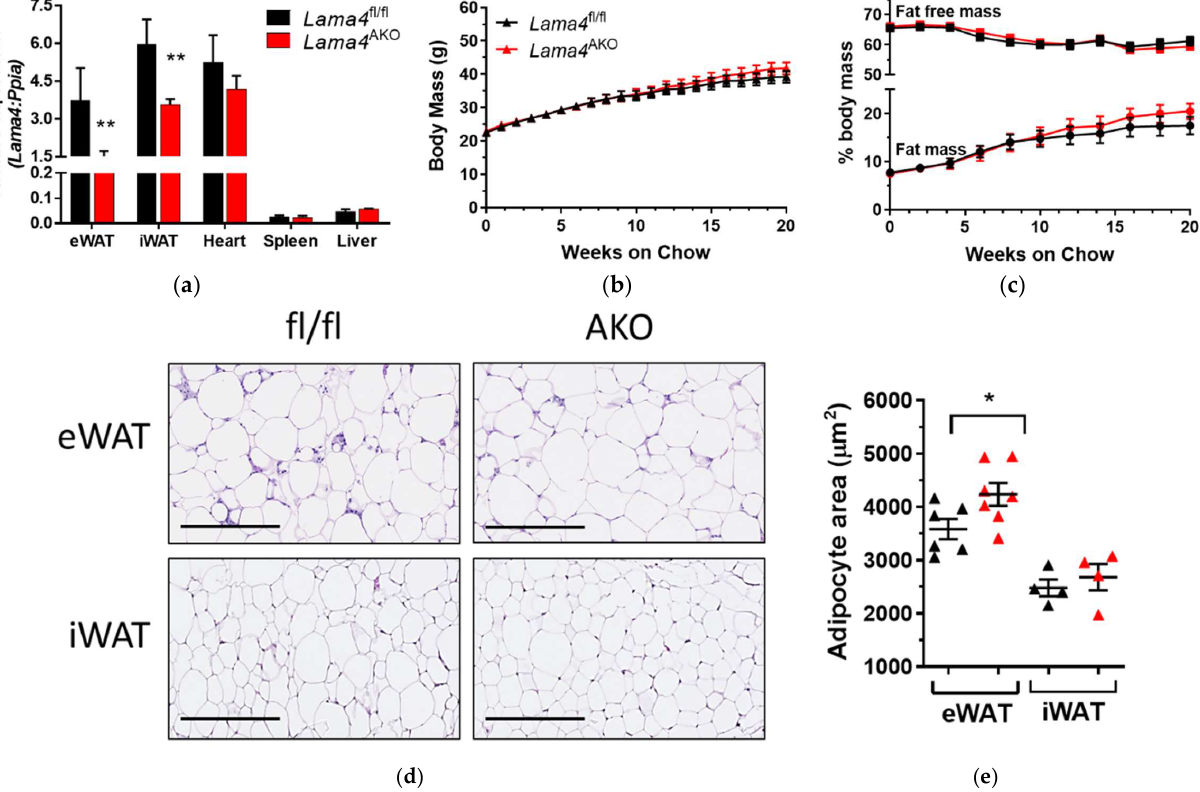
Figure 3. Mice with adipocyte-specific LAMA4 deletion exhibit increased eWAT adipocyte area when maintained on a chow diet. Male Lama4 fl/fl (fl/fl) and Lama4 AKO (AKO) mice were provided a chow diet from weaning until 24 weeks of age; body weight was measured weekly and body composition was measured via NMR every other week. ( a ) Knockdown of Lama4 was confirmed in eWAT and iWAT; heart is shown as a positive control ( n = 3–4 per genotype). Black bars represent Lama4 fl/fl mice and red bars represent Lama4 AKO mice. ( b ) There were no differences in body weight between Lama4 fl/fl (black) and Lama4 AKO mice (red) ( n = 16–18 per genotype). ( c ) Adiposity did not differ between Lama4 fl/fl (black) and Lama4 AKO mice (red) ( n = 16–18 per genotype). ( d ) Representative images of H&E-stained eWAT and iWAT ( n = 4–6 per group). ( e ) Adipocyte area is significantly increased in eWAT, but not in iWAT, of chow-fed Lama4 AKO mice ( n = 4–7 per genotype per tissue). Black triangles represent Lama4 fl/fl mice and red triangles represent Lama4 AKO mice. * p < 0.05 and ** p < 0.01 between genotypes. Scale bars = 250 μm.